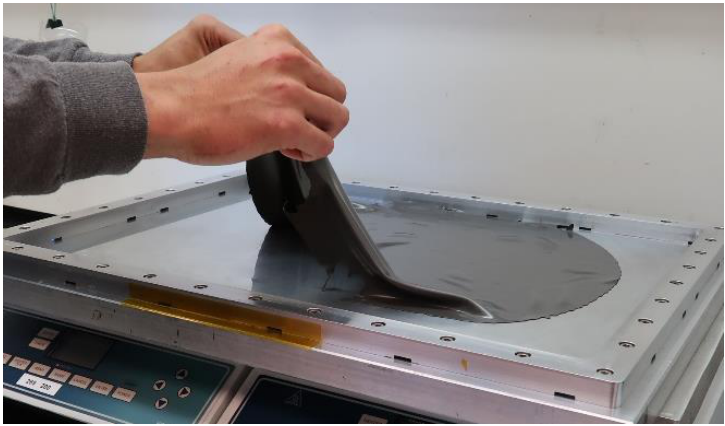
Figure 3. FPPC construct being removed from the mold.